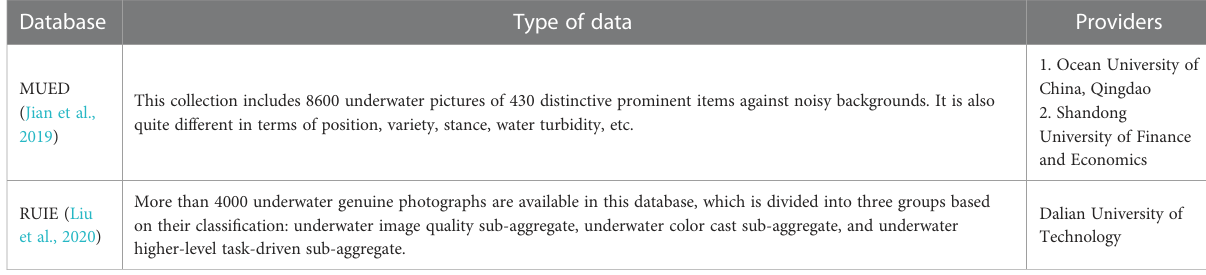
TABLE 1 Databases for underwater image